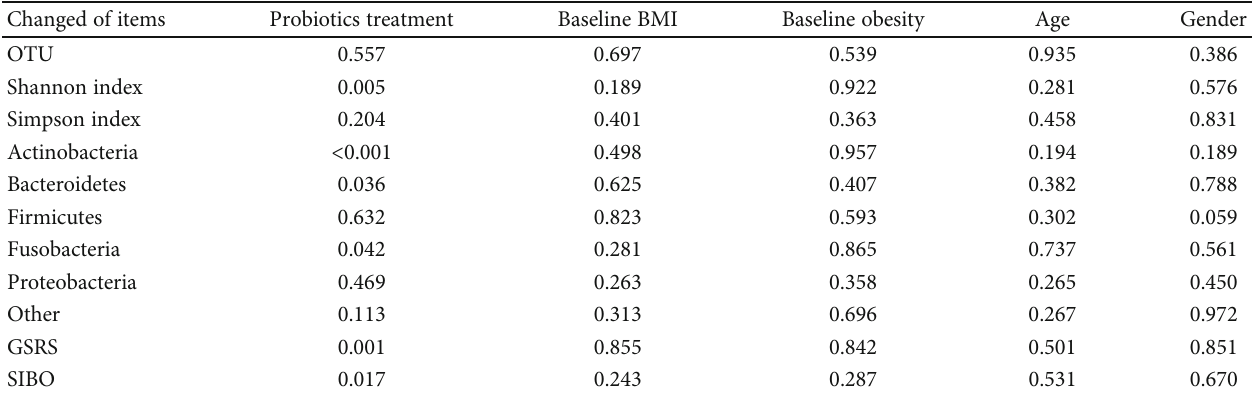
Table 4: Results of linear regression analysis ( P